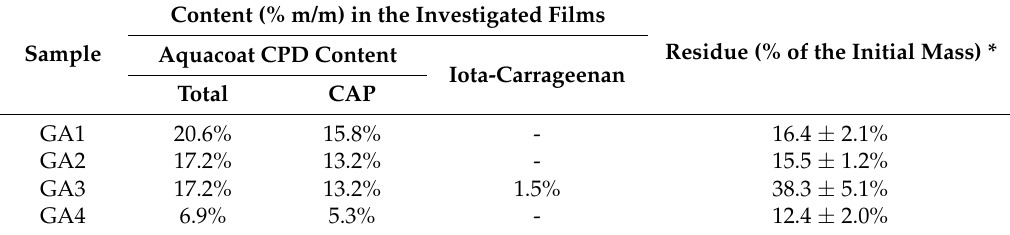
Table 2. Composition of the dry films (%m/m) and dry residues recovered after 3 h in 0.1 M HCl. Sample Sample